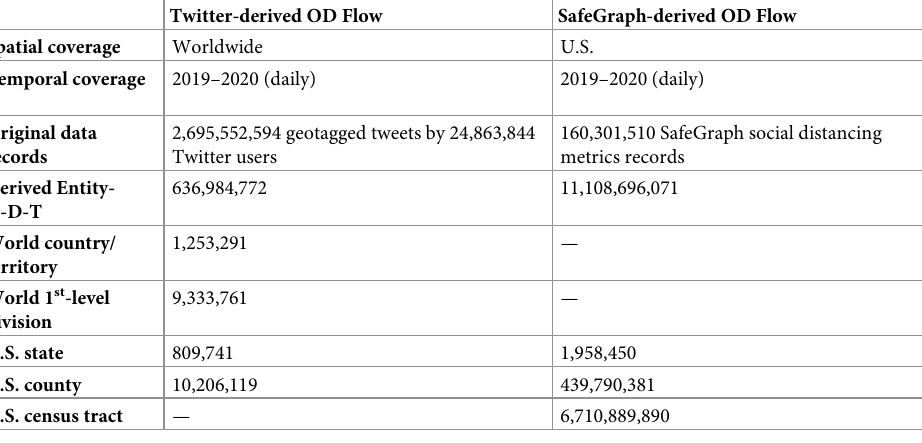
Table 1. Statistics of the derived daily OD flows from Twitter data and SafeGraph